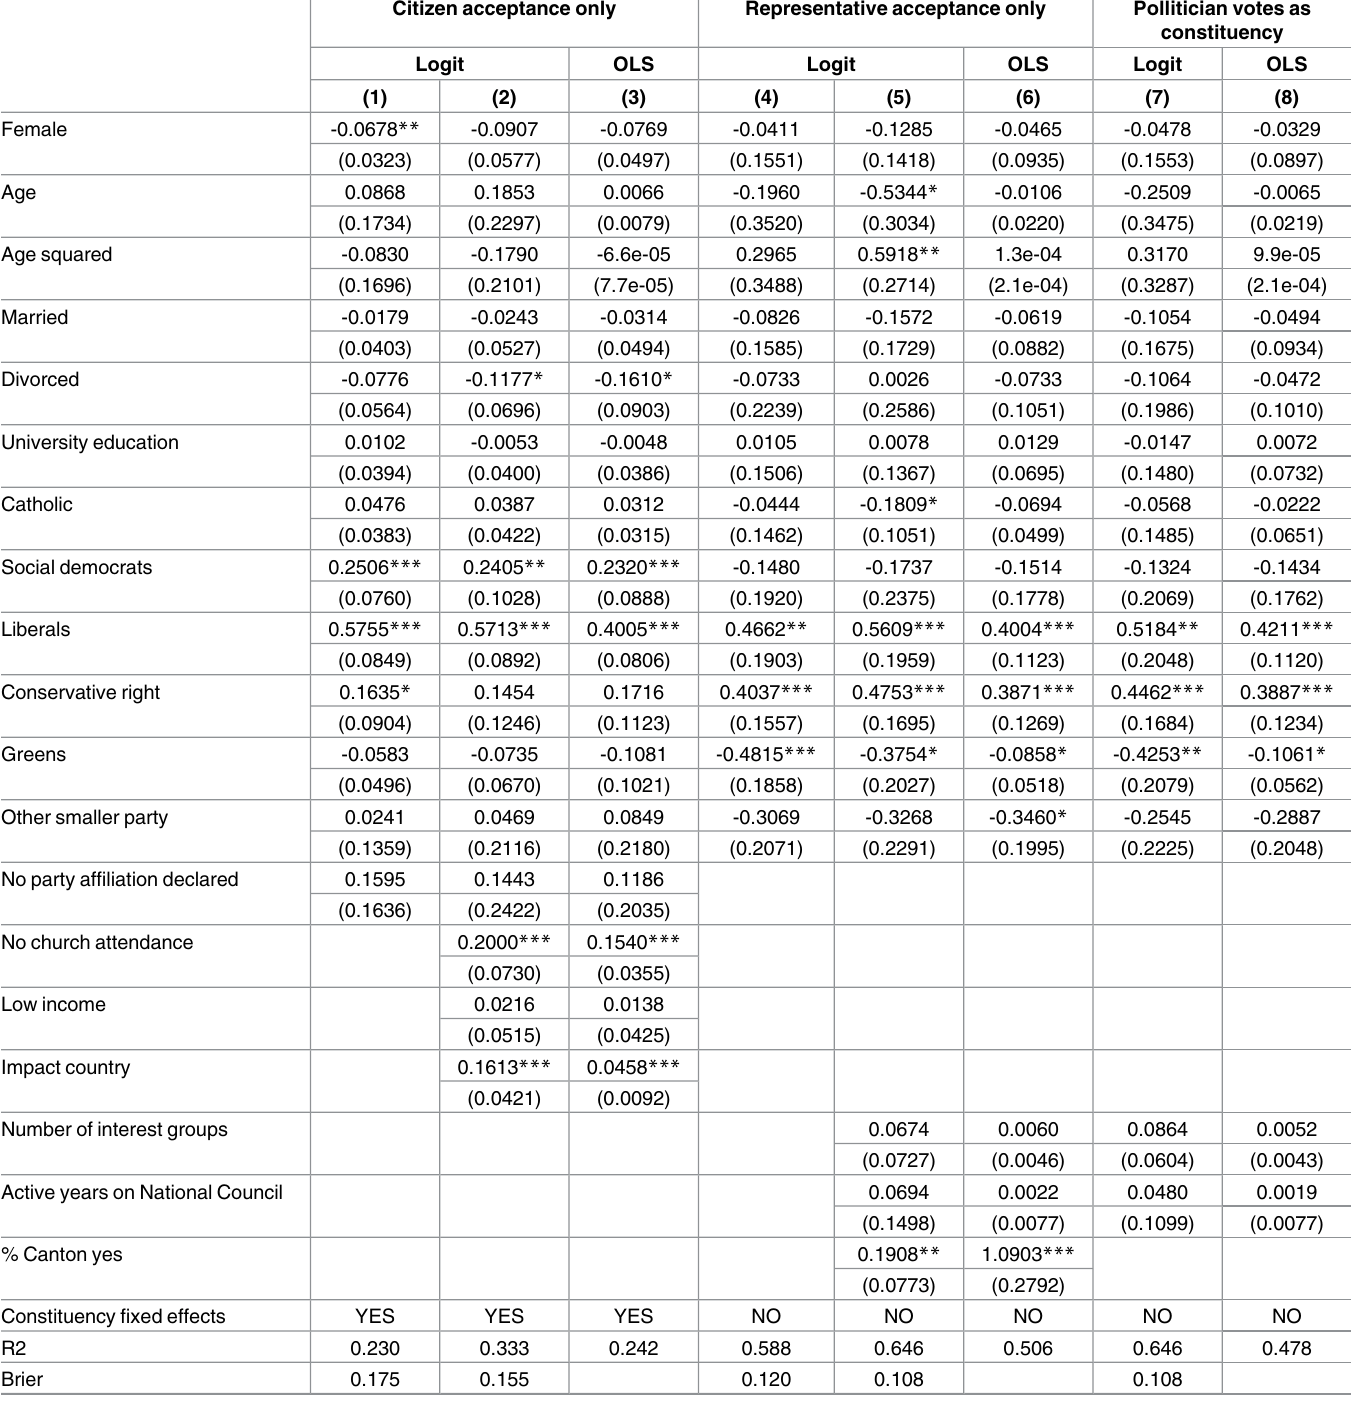
Table 2. Citizen, representative acceptanceof stem cell researchand representation of